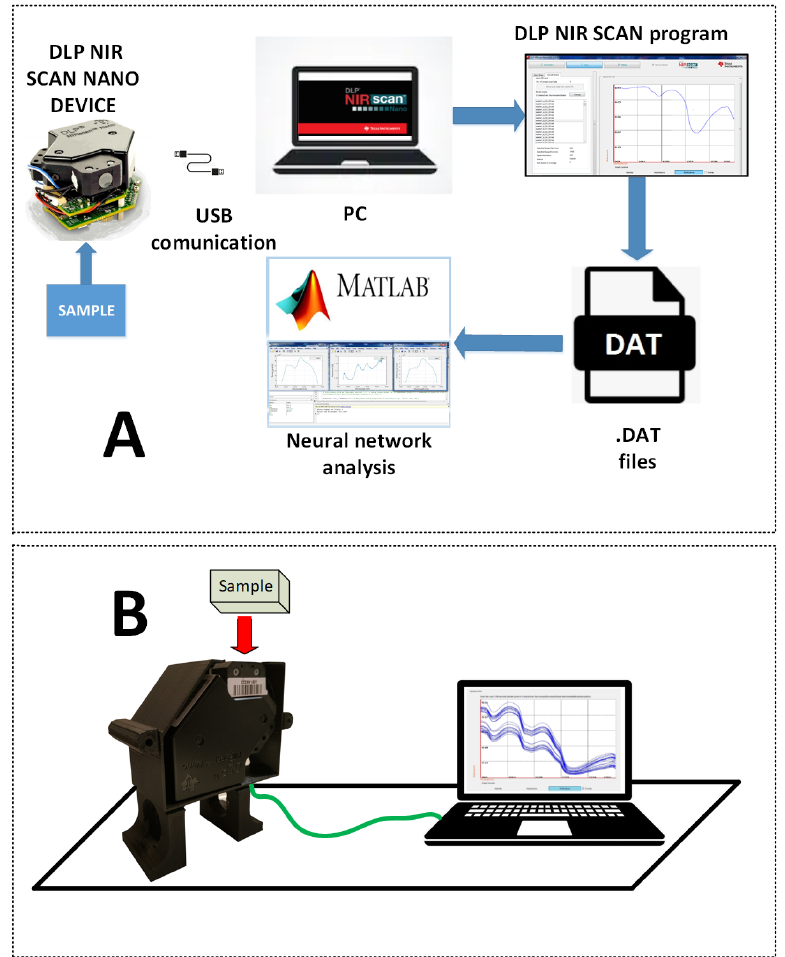
Figure 1. The measurement stand based on the DLP NIR EVM spectrometer: ( A )—a scheme of the data flow, ( B )—a general view of the